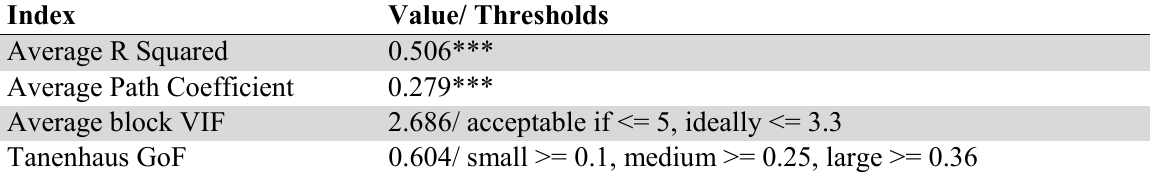
Model fit and quality